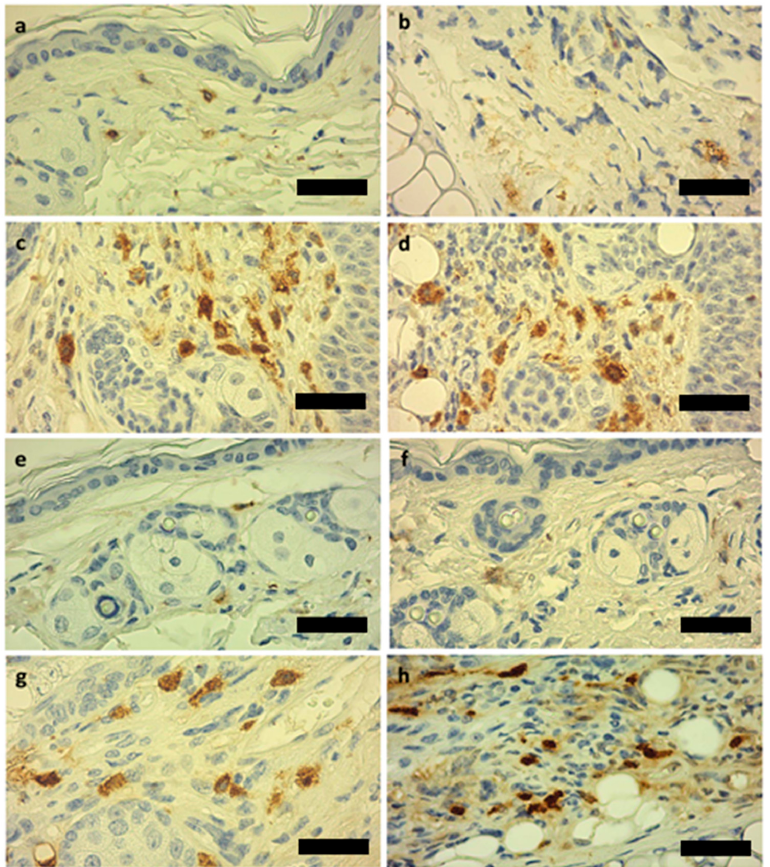
Figure 1. Histological analysis of mice chest skin and ear tissue samples, 500 × , DAB-hematoxylin, scale bar = 20 µ m. ( a ) Chest skin with low mast cell infiltration observed in wild-type (HPV − ) mice. ( b ) Normal ear with low mast cell infiltration observed in HPV − mice. ( c ) Mast cell infiltration observed in chest skin of K14-HPV16 (HPV + ) transgenic mice. ( d ) Mast cell infiltration observed in ear tissue of HPV + mice. ( e ) Chest skin of an HPV − mouse with DMBA treatment. ( f ) Ear tissue of an HPV − mouse with DMBA treatment. ( g ) Chest skin of HPV + transgenic mouse with DMBA presence. ( h ) Ear tissue of HPV + transgenic mouse with DMBA presence.